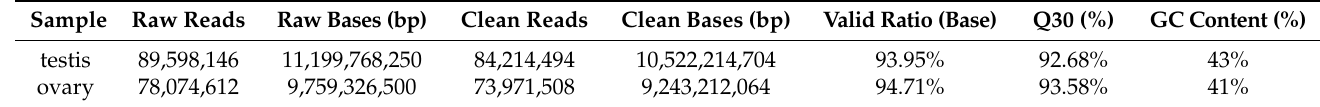
Table 1. Statistical assessment of transcriptome sequencing data.